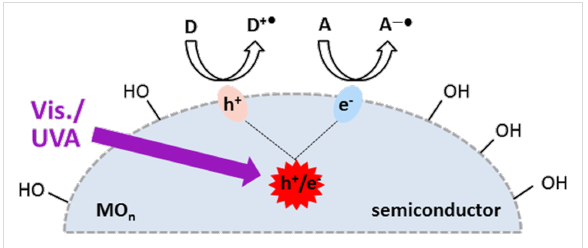
Figure 1: Production and utilization of h + and e – by photoactivation of a